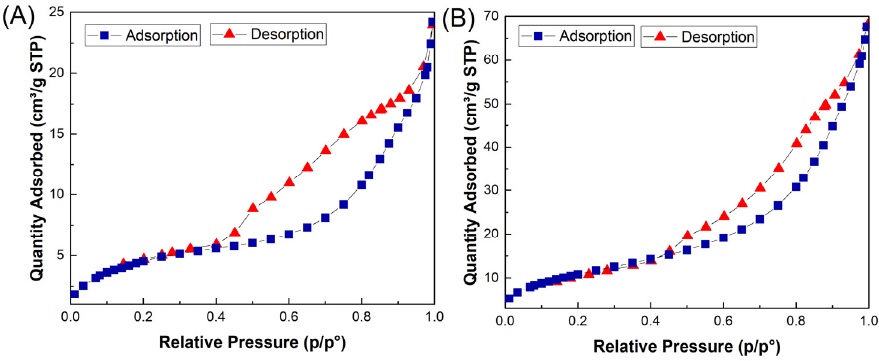
Figure 5. N 2 adsorption/desorption isotherms of Fe 3 O 4 @CuO ( A ) and MMIP ( B ). Figure 5. N2 adsorption/desorption isotherms of Fe3O4@CuO ( A ) and MMIP ( B ).